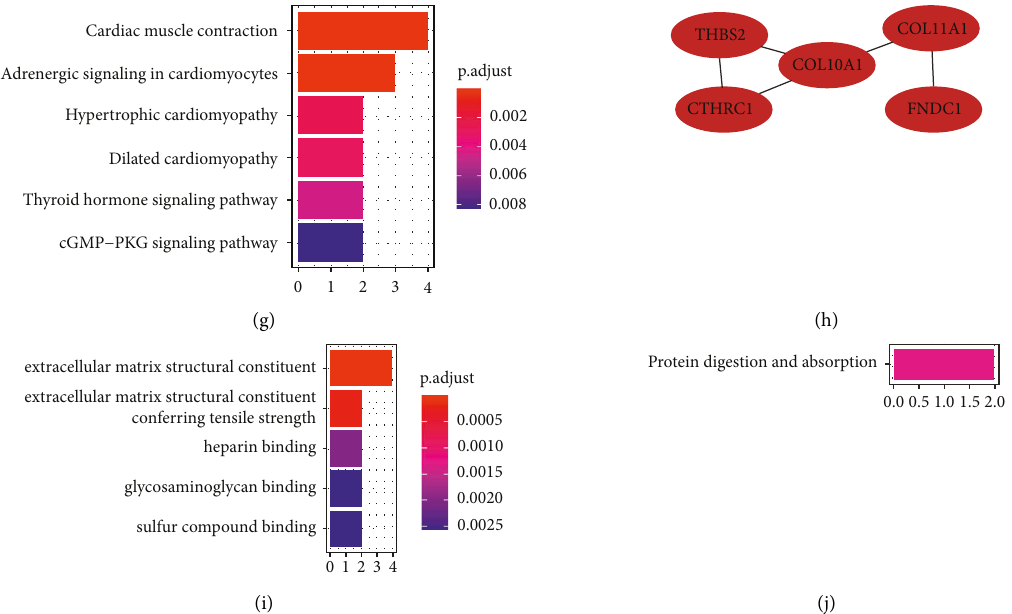
Figure 5: Bone metastasis-related gene module identification. (a) A dendrogram generated via the clustering of dissimilarity based on consensus topological overlap with corresponding modules being shown based on the colored rows corresponding to modules containing genes that were highly connected with one another. (b) Blue module co-expression network, with the hub gene in the network center. (c) GO analysis of genes in the blue module. (d) KEGG analysis of genes in the blue module. (e) Turquoise module co-expression network, with the hub gene in the network center. (f) GO analysis of genes in the turquoise module. (g) KEGG analysis of genes in the turquoise module. (h) Brown module co-expression network, with the hub gene in the network center. (i) GO analysis of genes in the brown module. (j) KEGG analysis of genes in the brown